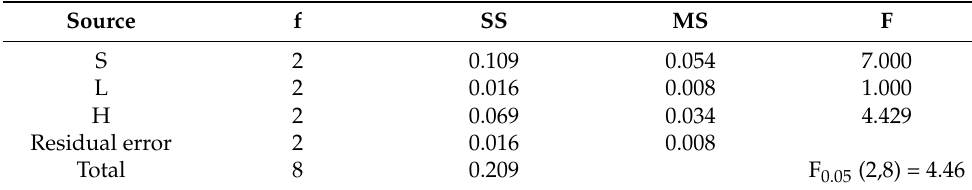
Table 4. Analysis of variance for the maximum scour depth.